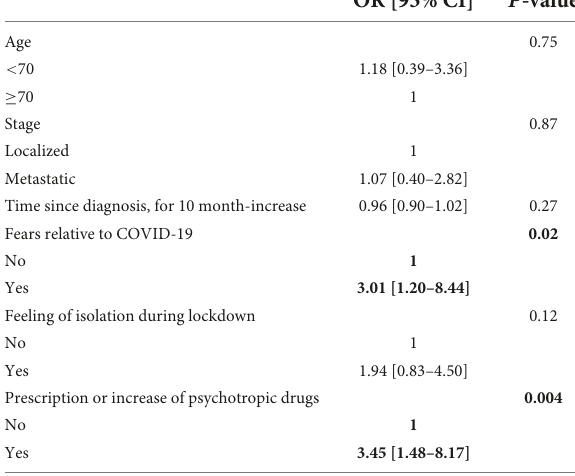
TABLE 4 Multivariable model of post-traumatic stress disorder (PTSD) symptoms during the first coronavirus disease (COVID-19) lockdown in breast cancer (BC) patients ( N =